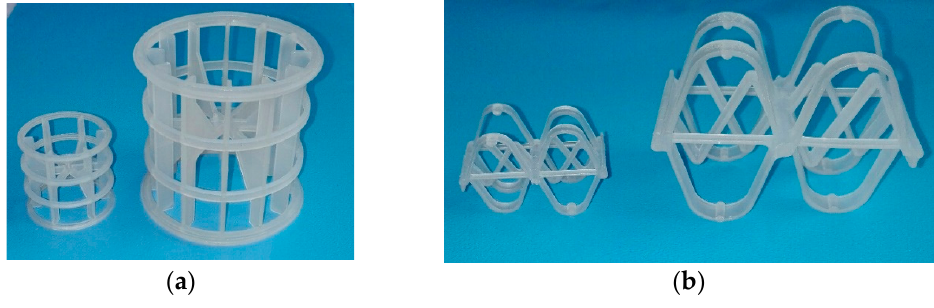
Figure 1. Packings: ( а ) Ralu–Flow; ( b ) Plastic Raschig Super–Ring.